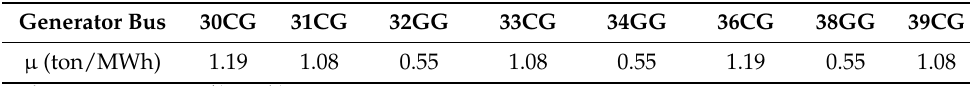
Table A1. Generators carbon emission factor.